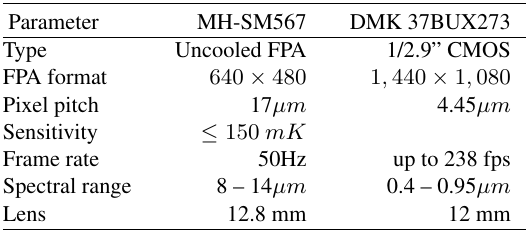
Table 2. Thermal and visible cameras specification